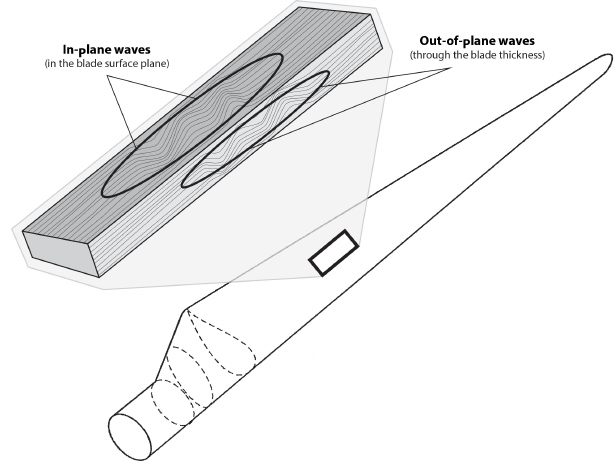
Figure 1. Examples of localized fiber waviness observed both on the surface (IP waves) and through the thickness (OP